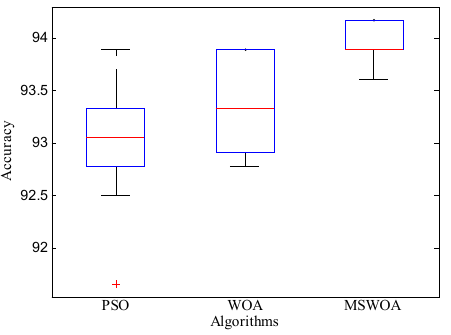
Figure A2. Box plots of fault diagnosis results of the Sallen–Key band pass filter circuit.